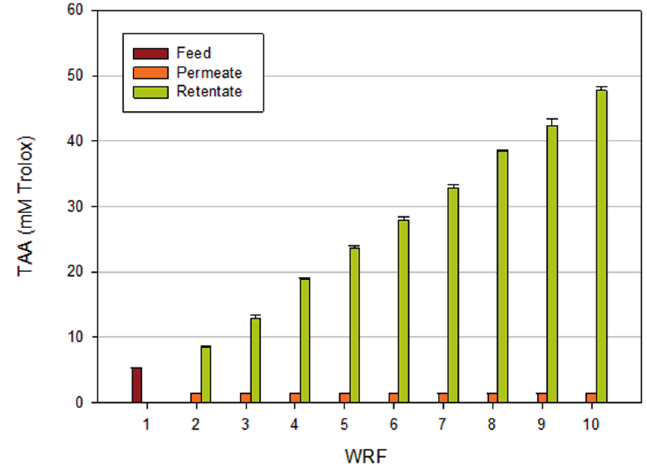
Figure 7. TAA as a function of WRF for permeate and retentate streams of clarified artichoke extracts treated with NP030